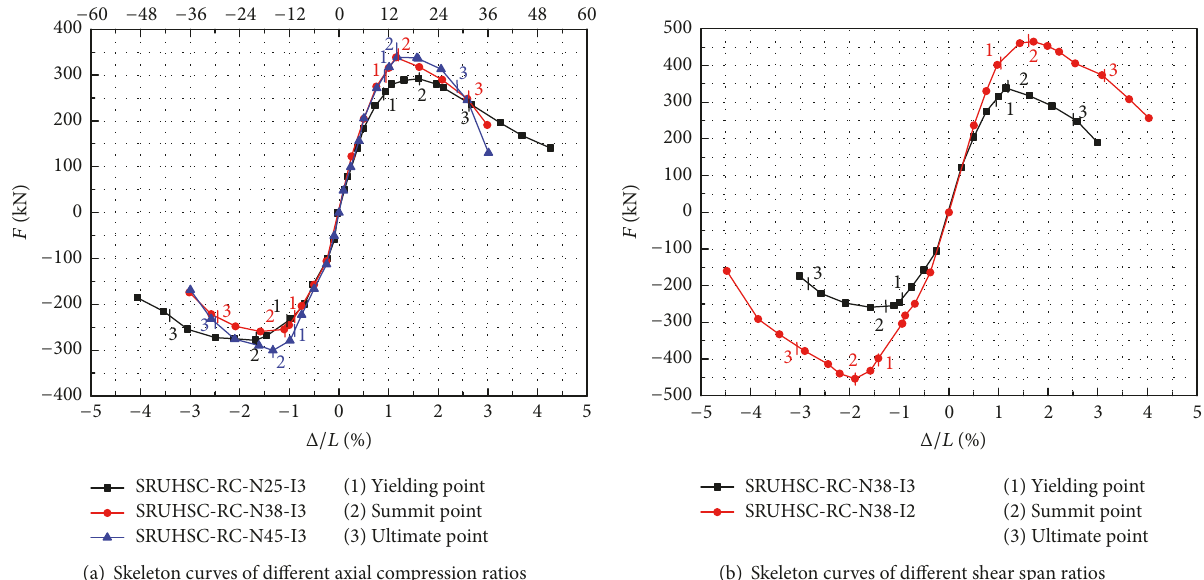
Figure 7: Skeleton curve comparison of the SRUHSC frame.